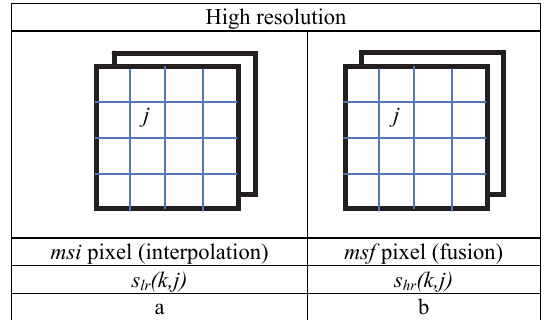
Table 1. Definition and notation of input, intermediate and output pixels of pan-sharpening: (a) multispectral pixel with K spectral bands (index i is used), (b) panchromatic pixel in low resolution (index i is used).